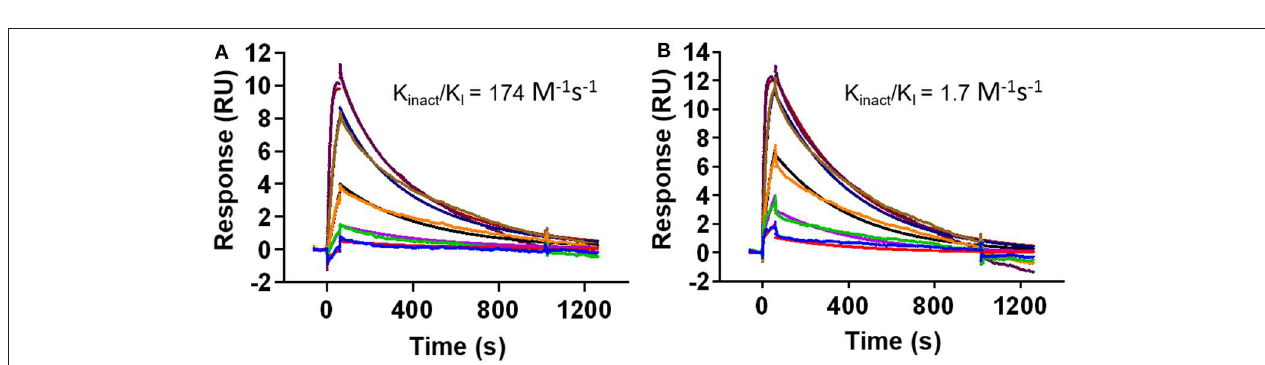
FIGURE 4 | DGY-06-116 shows a slow inactivation rate. (A) Covalent DGY-06-116 and (B) non-covalent analog NJH-01-111. Data from each interaction were analyzed using both a 1:1 kinetic model and a two-state covalent interaction (p-loop movement) model for calculation of k inact / K I